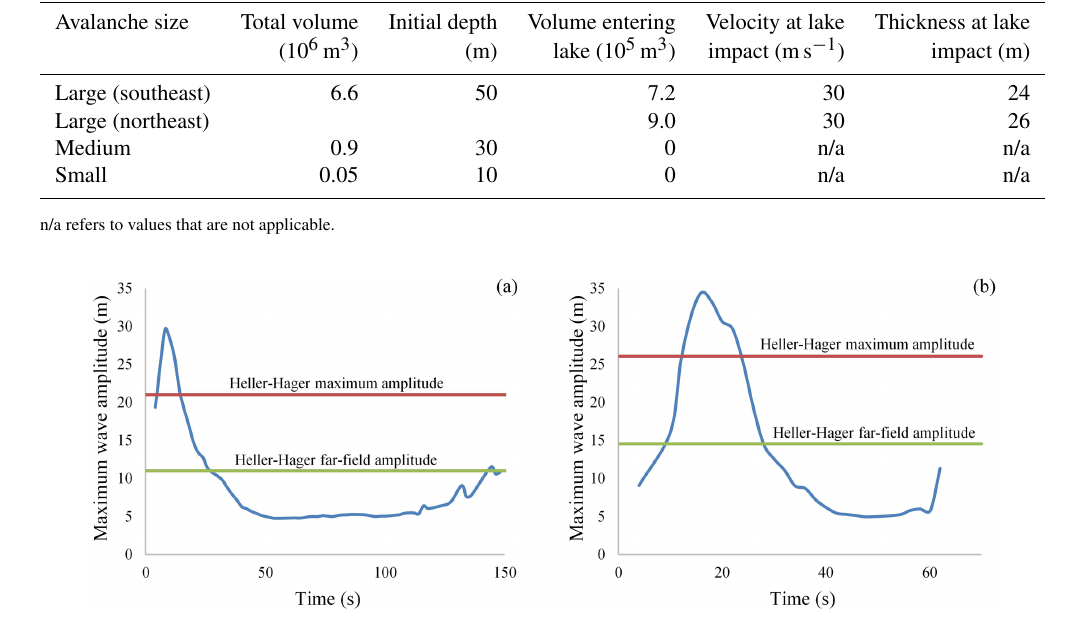
Figure 6. Maximum amplitude of the leading impulse wave across its initial trajectory, based on a large avalanche entering from the south- east (a) and northeast (b) in 2045, showing corresponding wave amplitudes from the Heller–Hager